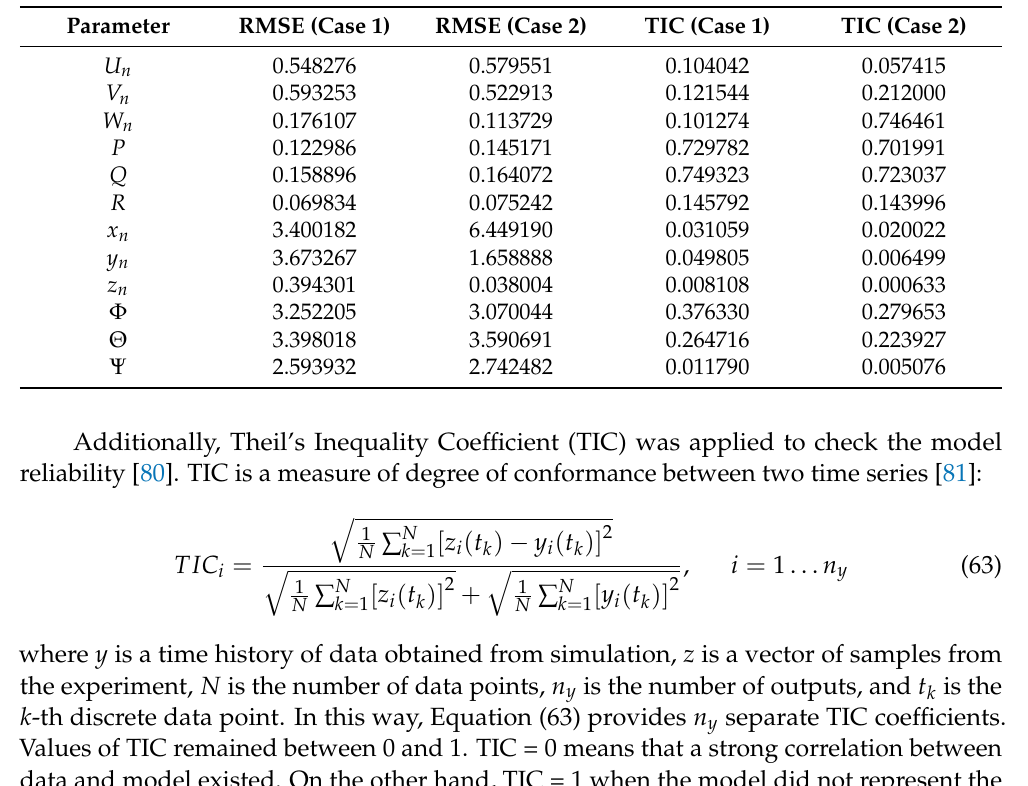
Table 6. Root mean square